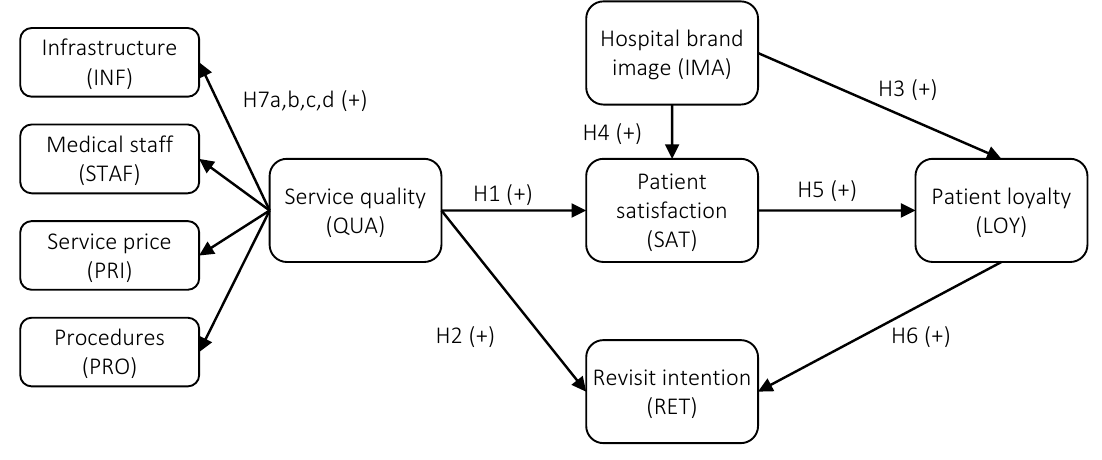
Figure 1. Conceptual